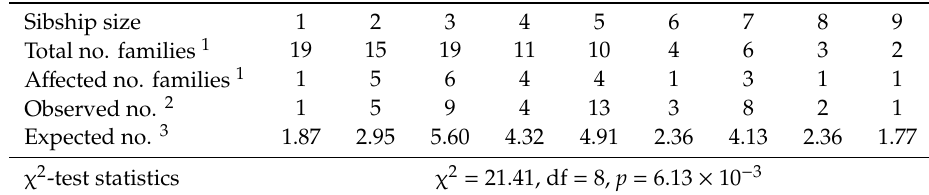
Table 3. Basic statistical analysis of the distribution of observed number of endemic CH versus expected number under random distribution within each nuclear family according to the sibship size.